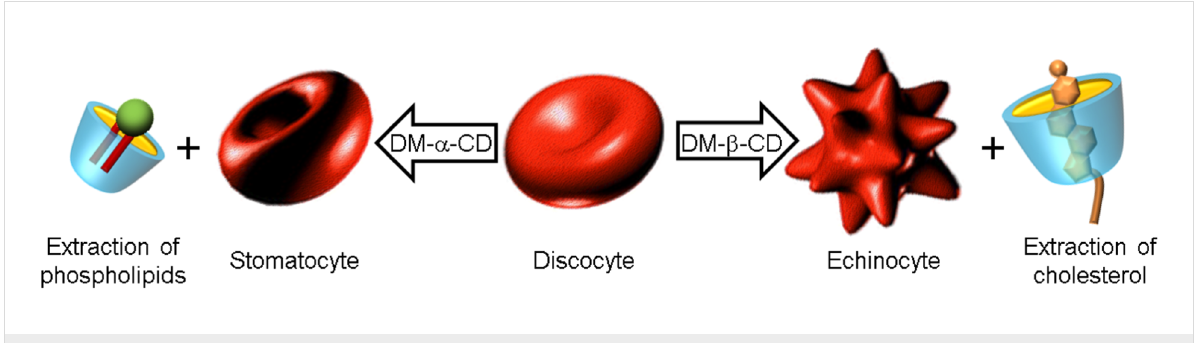
Scheme 2: Proposed mechanism for morphological changes in erythrocytes induced by methylated CDs.